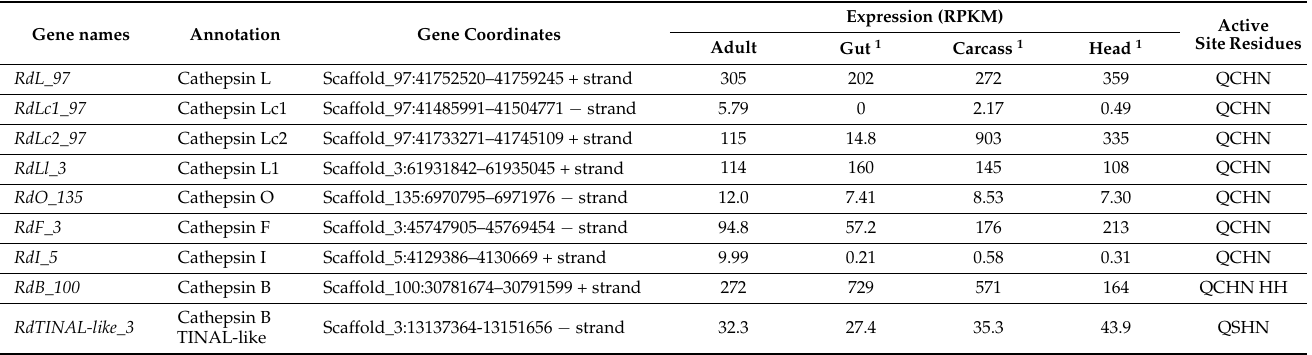
Table 5. General characteristics of R. dominica cathepsins (gene coordinates, expression and enzyme active site